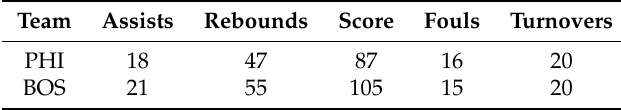
Table 1. The box score of the game between Philadelphia 76ers (PHI) and Boston Celtics (BOS) in the 2018–2019